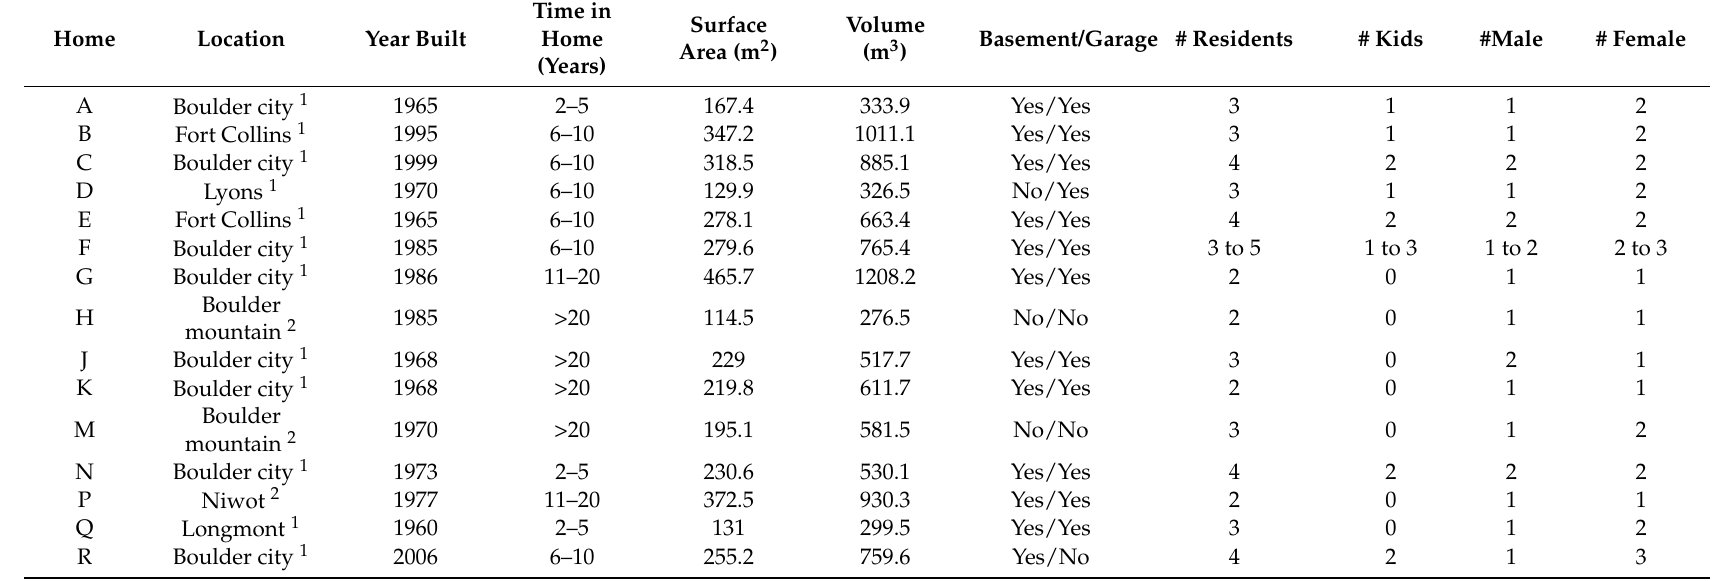
Table 1. Physical attributes and inhabitant characteristics of study